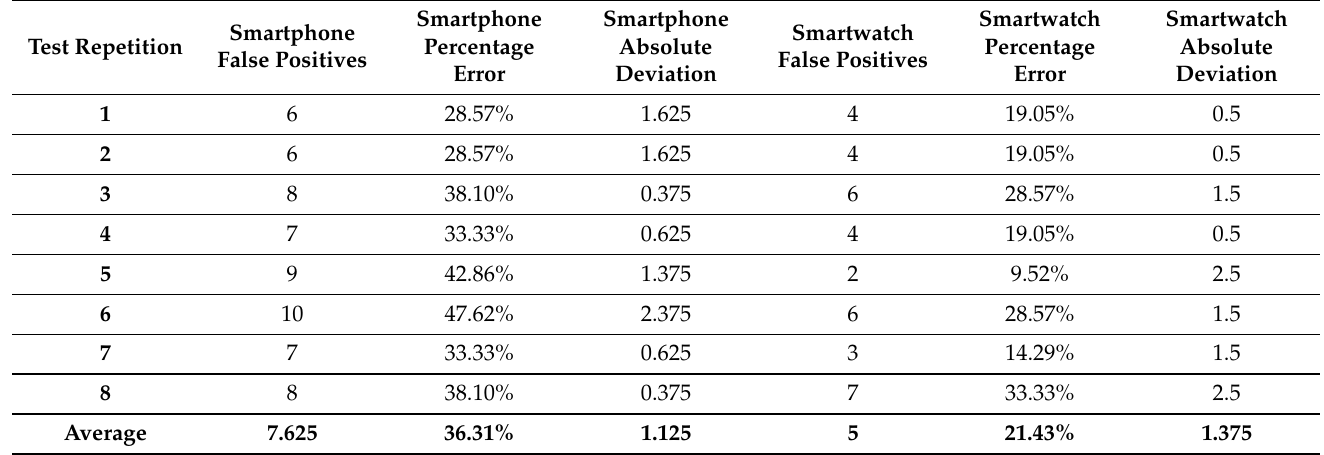
Table 1. Test 1. Percentage error and false